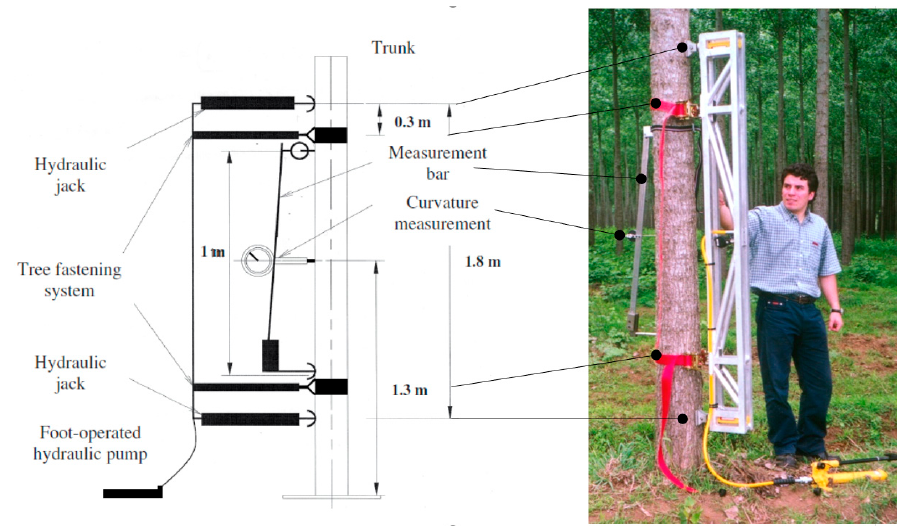
Figure 6. Characteristics of the Rigidimeter in its final version (from Pâques and Rozenberg, 2009) and setting up in an experimental trial of Populus in Chile.